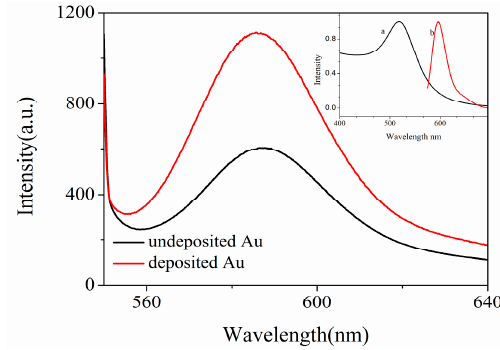
Figure 8. The fluorescence spectra of RRA-DNA obtained on Au NPs/PSiMC sensor substrate and PSiMC substrate without Au NPs (the concentration of RRA-DNA is 1 µM). The inset map shows ( a ) the absorption spectrum of Au NPs and ( b ) the emission spectrum of RRA.